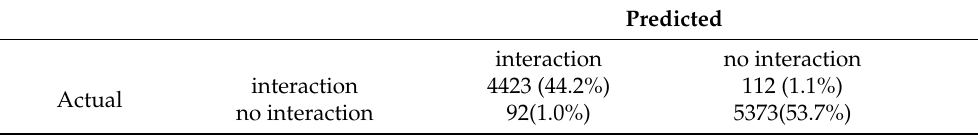
Table A8. Exemplary confusion matrix for interaction prediction with our model the ternary complex 6BN8 (one of the best scoring complexes with an AUROC of 0.99, see Table A7). True/false positives and true/false negatives are averaged across multiple different surfaces patches (see Section 2). The threshold was set to